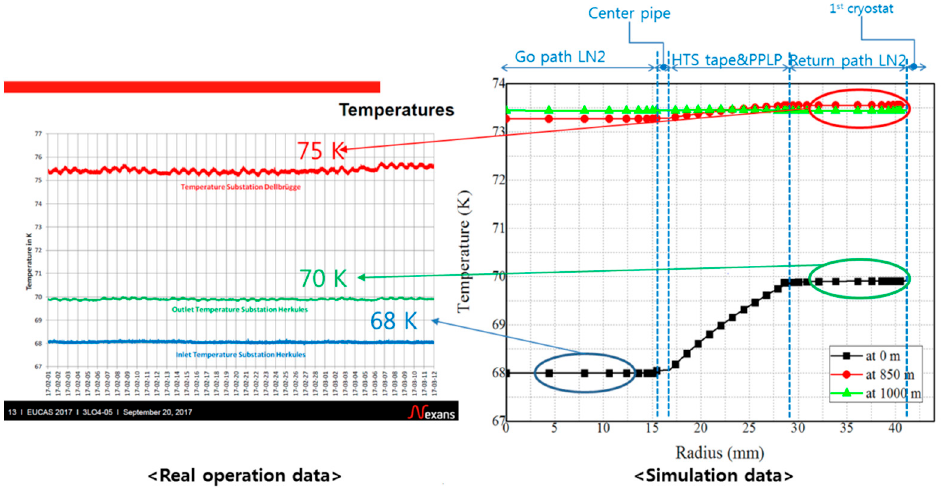
Figure 12. Comparison of temperature results between actual operation and simulation.